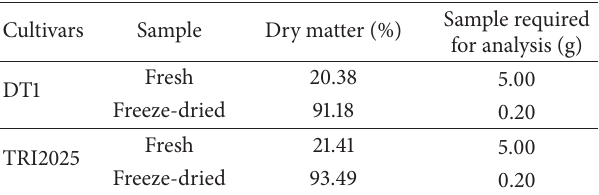
Table 1: Comparison of dry matter % and the sample required for analysis of cultivars DT1 and